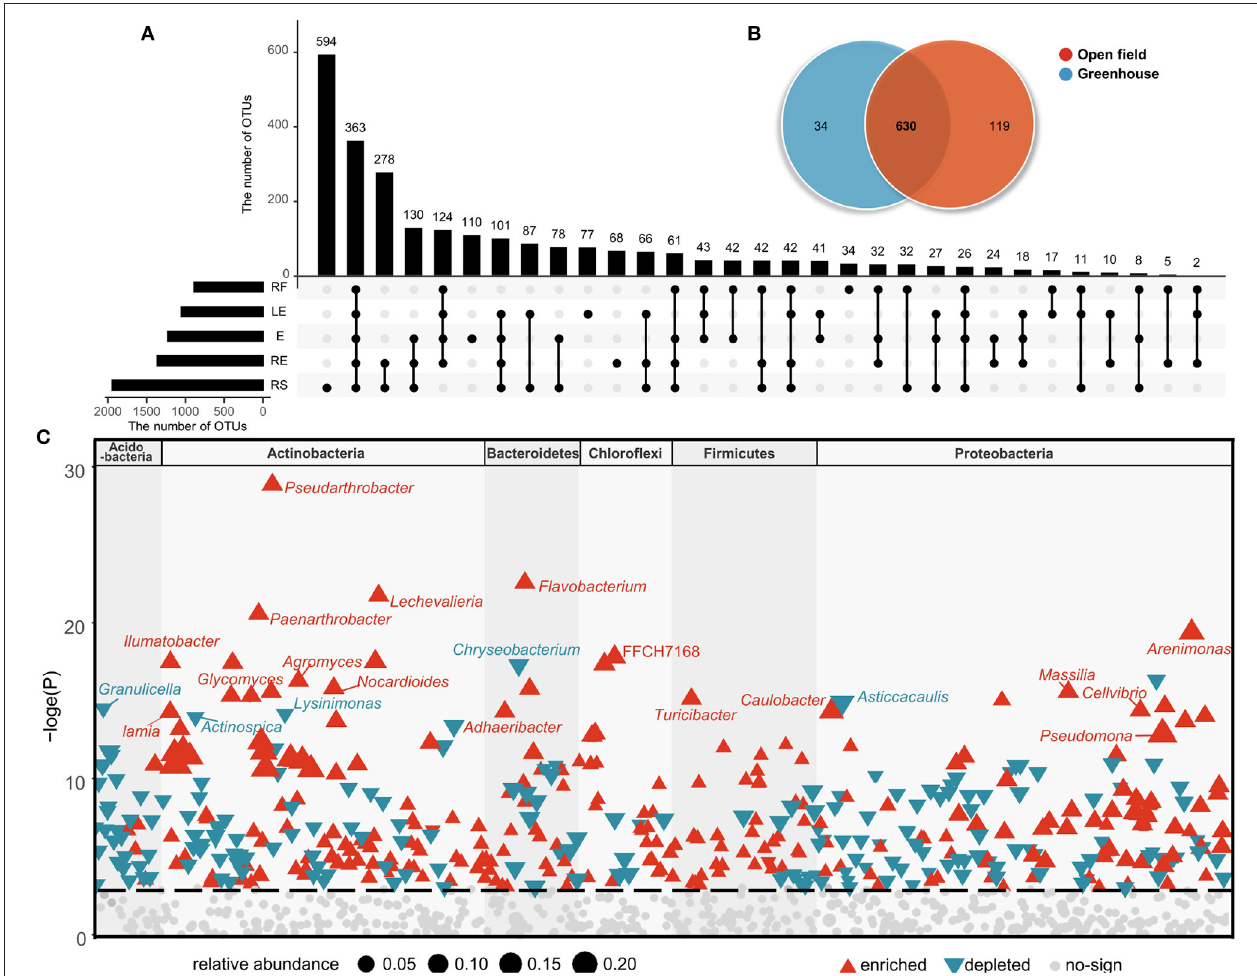
FIGURE 2 | Unique and shared OTUs present in the different ecological compartments (A) and cultivation environments (B) . OTUs changes significantly in field cultivation compared to greenhouse cultivation (C) . Red represents OTU that is significantly enriched, blue represents OTU that is significantly depleted, and the different blocks represent phylum to which OTU